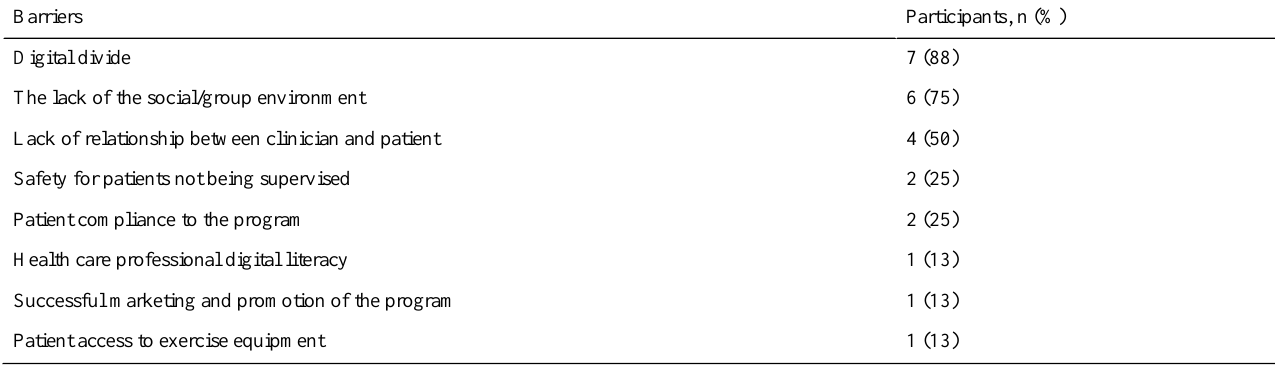
Table 3. Barriers to using a mobile pulmonary rehabilitation program